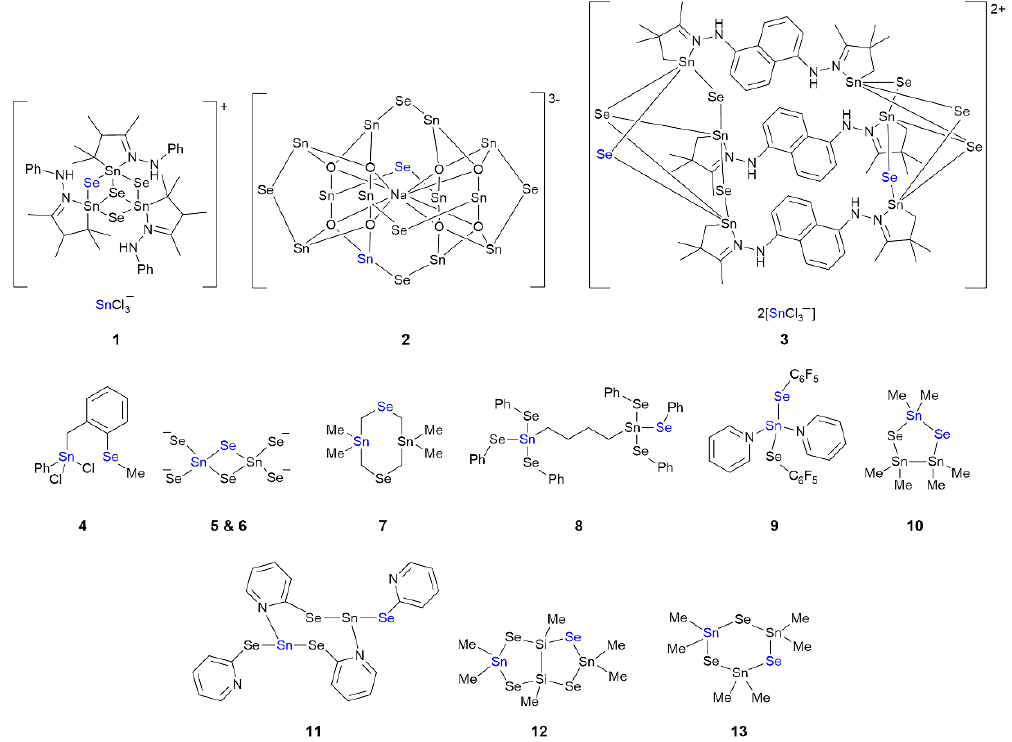
Figure 1. Chemical diagrams for tin compounds 1 – 13 . The atoms participating in the Sn ··· Se interactions are highlighted in blue.